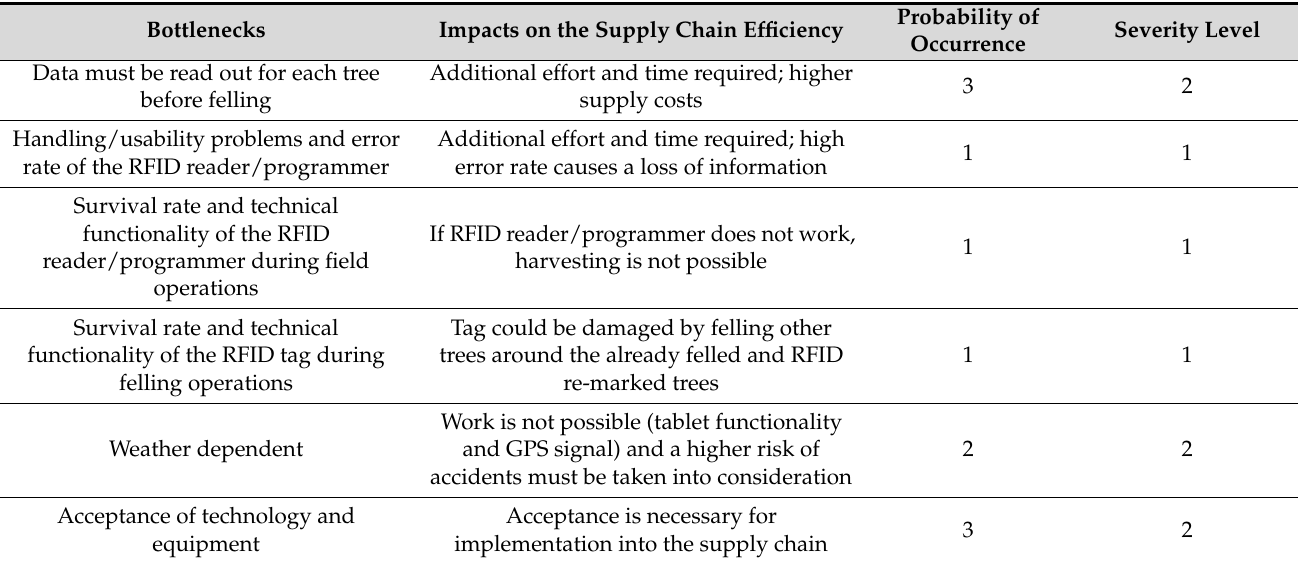
Table 6. Bottleneck and risk analyses of tree felling and RFID re-marking. Scale classes: low (1), moderate (2), and high